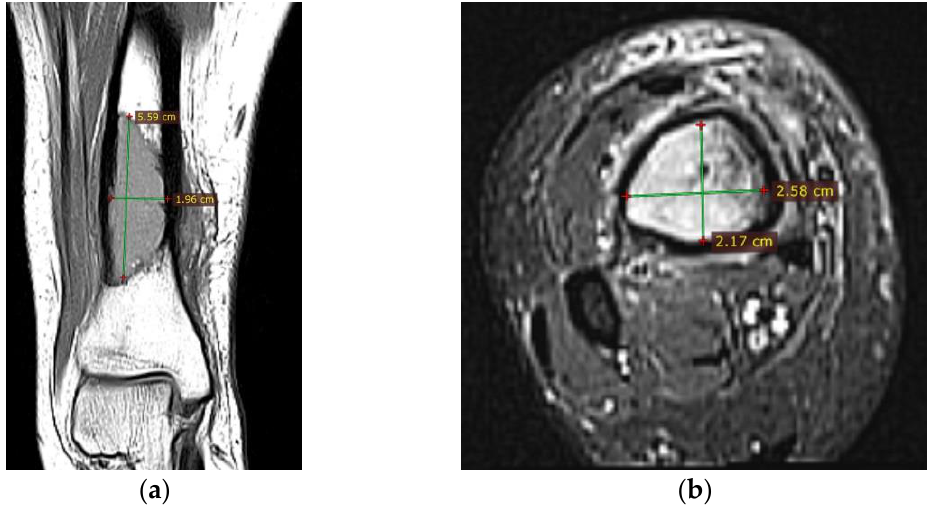
Figure 3. ( a ) MRI T1 coronal section, hyposignal lesion; ( b ) MRI T1 fat sat, axial section.